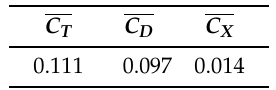
Figure 18. ( a ) Time history of force coefficients during a flapping cycle; ( b ) Distribution of 𝐶 𝑋 ̅̅̅ on the manta surface. Table 1. Cycle-averaged values of force coefficients.